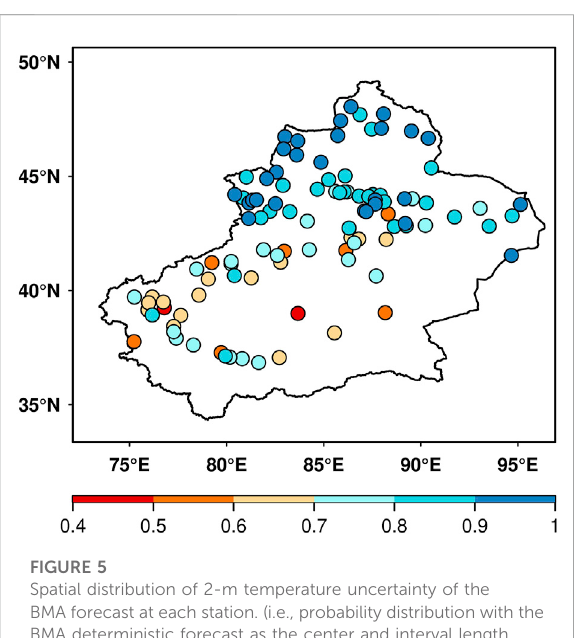
FIGURE 5 Spatial distribution of 2-m temperature uncertainty of the BMA forecast at each station. (i.e., probability distribution with the BMA deterministic forecast as the center and interval length of 2 °